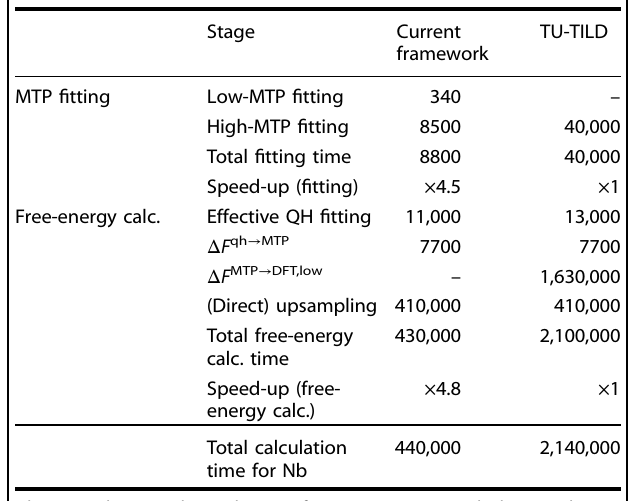
Table 2. CPU-time estimate (in core hours) for different stages of the free-energy calculation for Nb (PBE, 11 valence electrons) using the current framework and using the previous TU-TILD methodology.